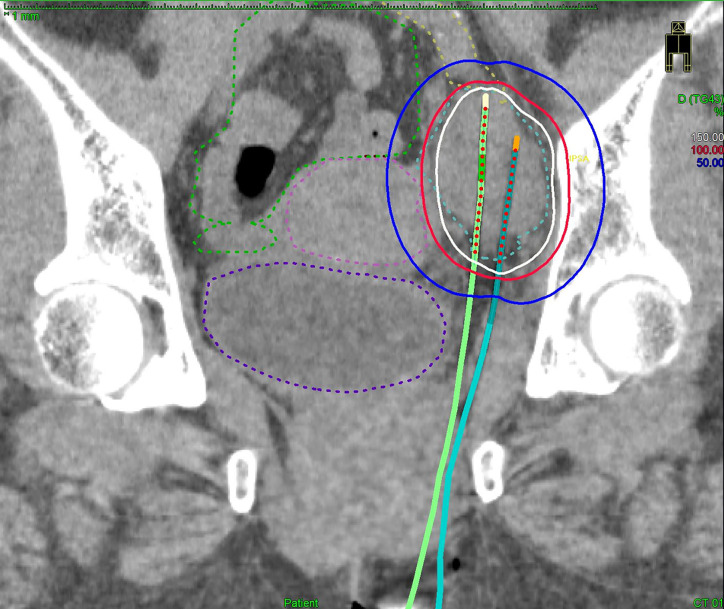
A coronal CT image of the bulkiest obturator node (blue dashed line), uterus (pink dashed line), bowel (green dashed line), external iliac vessel (yellow dashed line), bladder (purple dashed line) receiving 50% (blue lines), 100% (red lines), and 150% (white lines) of the prescription dose (6 Gy) from two implanted needles.